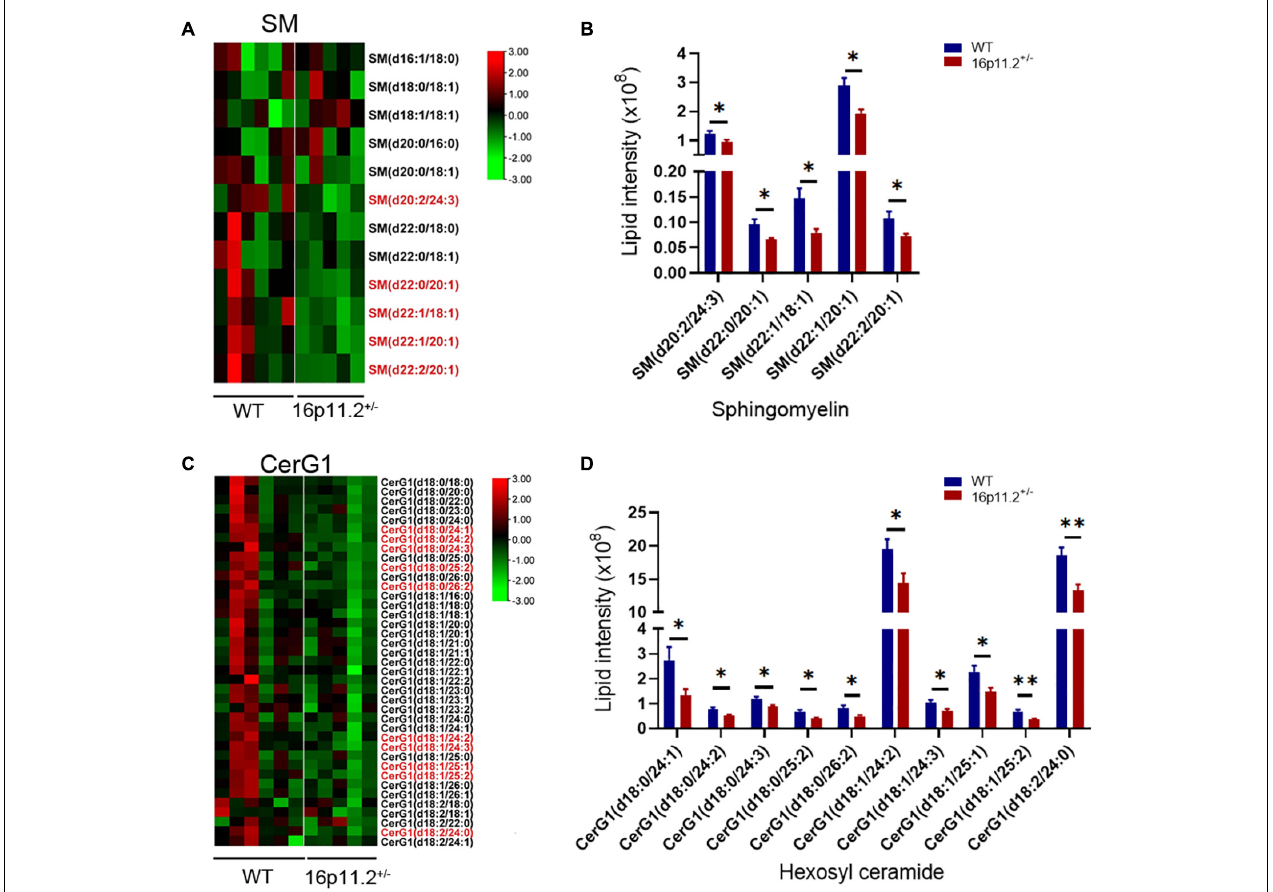
FIGURE 5 | Decreased SM and CerG1 species in 16p11.2 ± striatum. (A,C) Heatmaps of SM (A) and CerG1 (C) species identified in the striatum of P60 16p11.2 ± mice ( n = 5) and WT controls ( n = 6) by lipidomics analysis. The lipid species showing a significant change in level in 16p11.2 ± striatum are written in red. (B,D) Charts of comparing the “red” SM (B) and CerG1 (D) species, indicating their decreased levels in the striatum of 16p11.2 ± mice relative to WT controls (mean ± SEM, * p < 0.05/** p < 0.01 for unpaired t